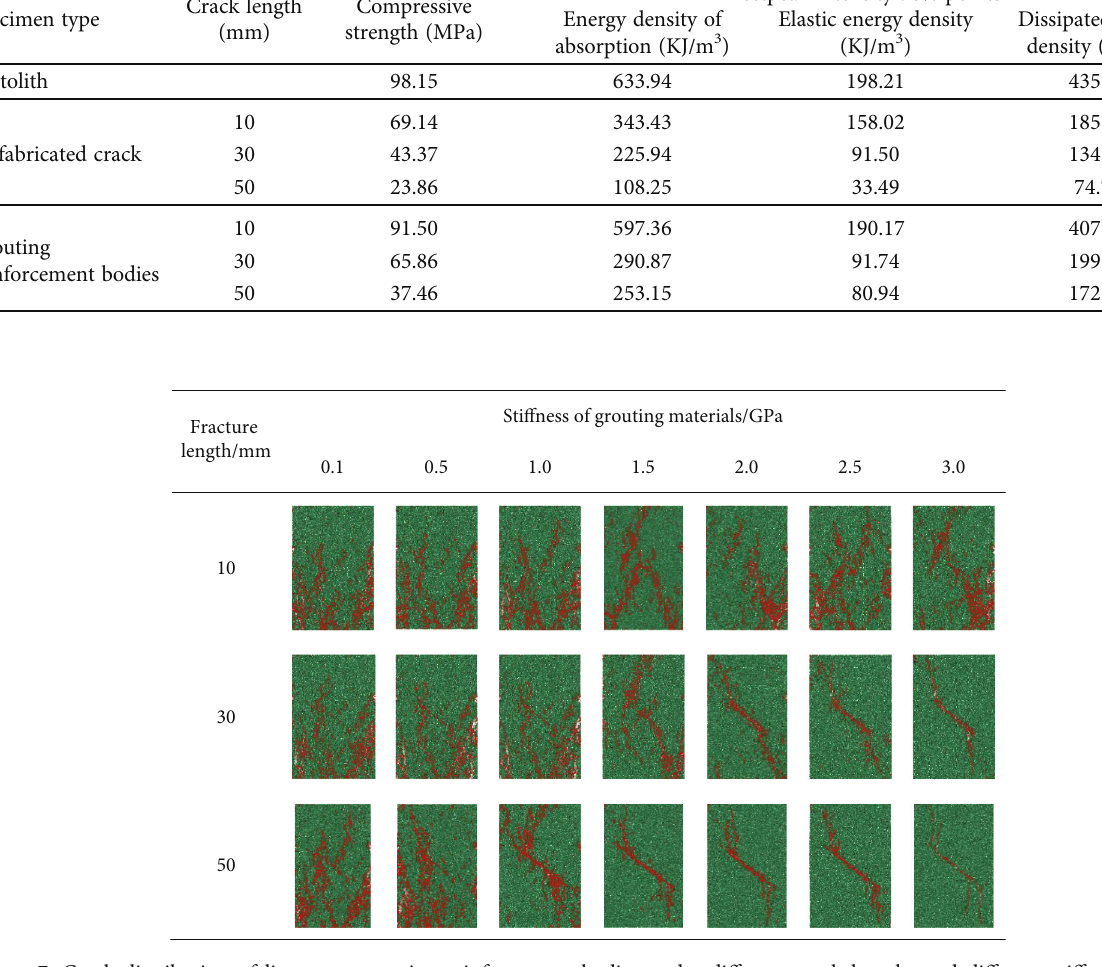
Figure 7: Crack distribution of limestone grouting reinforcement bodies under di ff erent crack lengths and di ff erent sti ff ness values of grouting stone